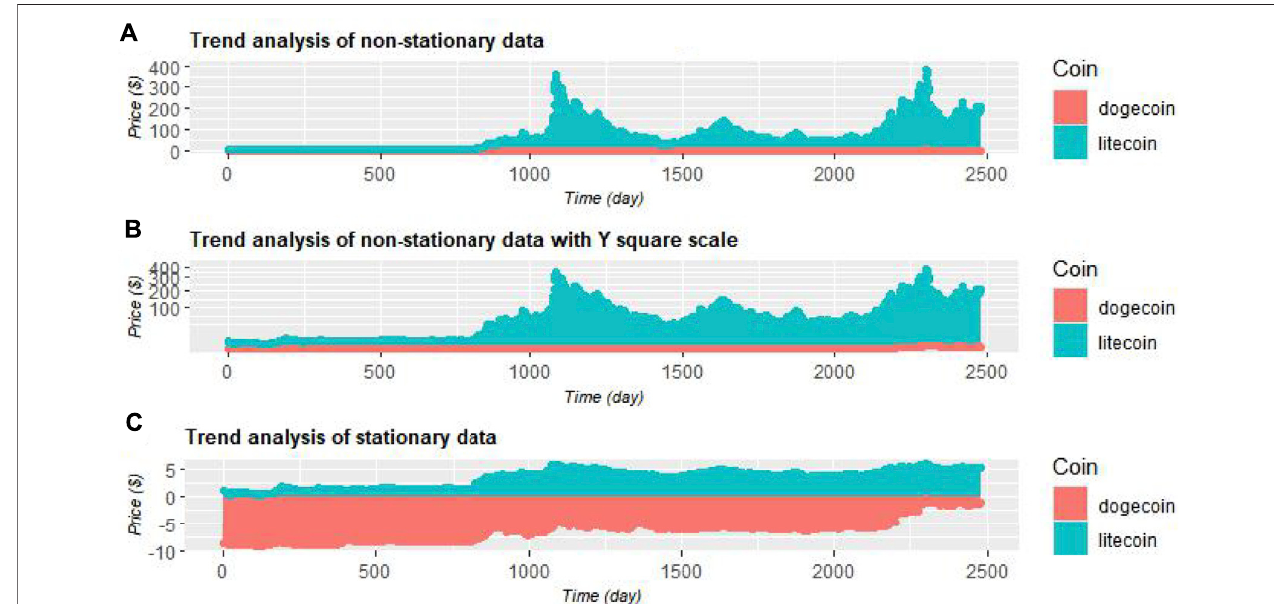
FIGURE 5 | Price trend analysis.